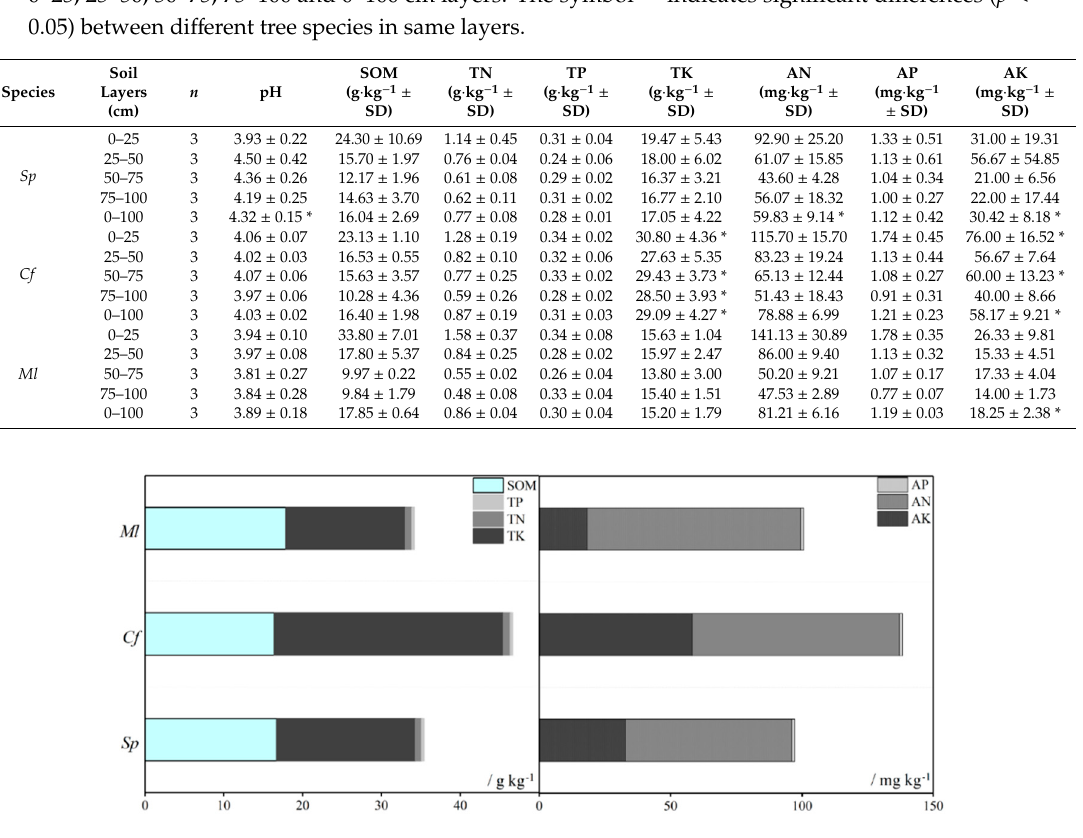
Table 2. Measured soil chemical properties including pH values, soil organic matter (SOM, g · kg − 1 ),